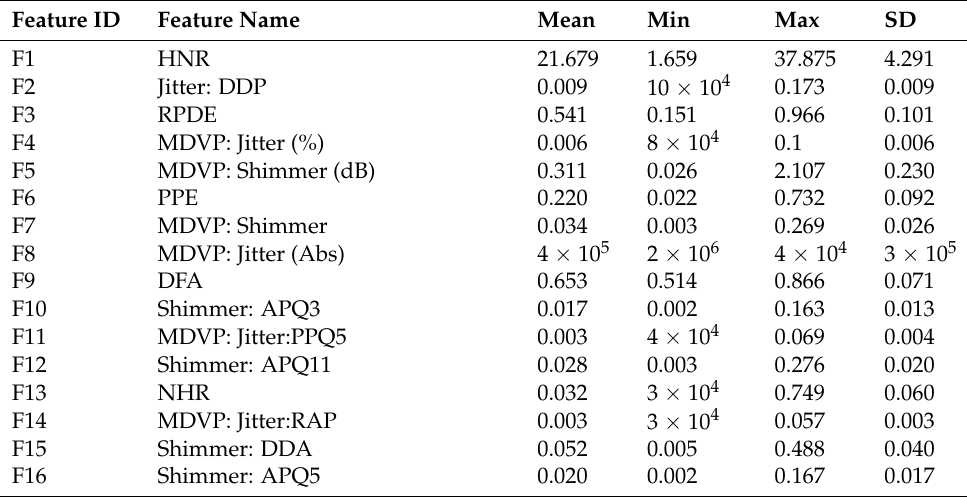
Table 2. The Total- and Motor-UPDRS, and 16 biomedical voice measures in Parkinson’s telemonitoring